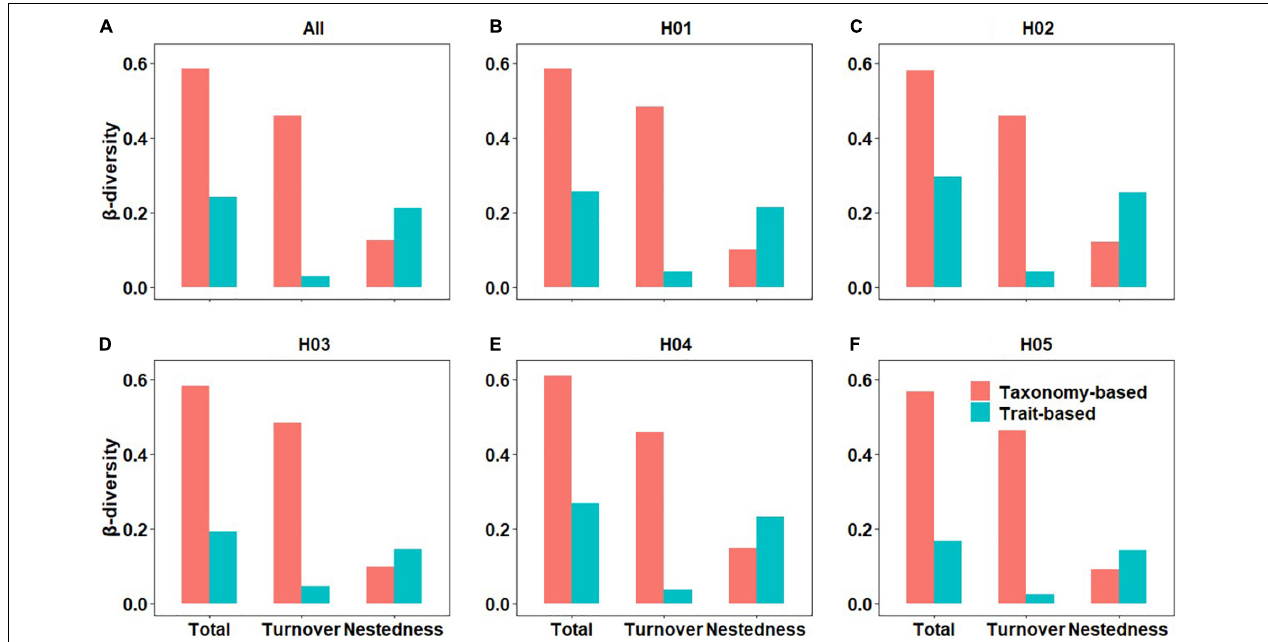
FIGURE 2 | Statistical descriptions of two facets (taxonomy- and trait-based) of the β -diversity components (i.e., total, turnover, and nestedness) for benthic diatoms at all sites (A) and different habitat groups ( B–F , H01–H05).